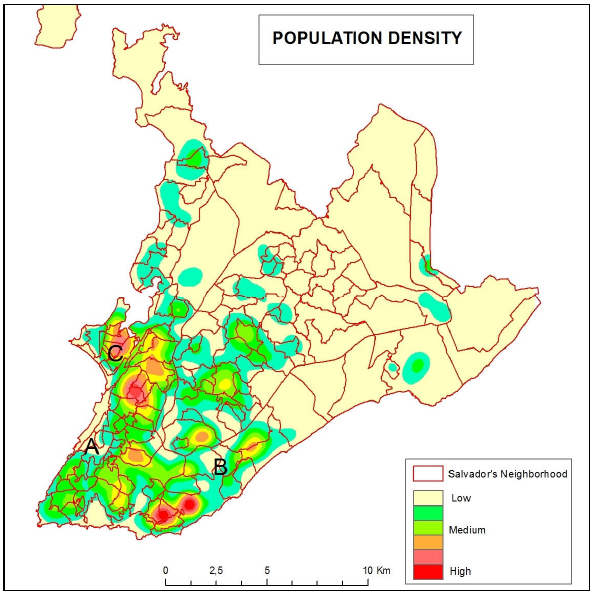
Figure 2. Map of population density. Note: kernel estimation based on census block population density).